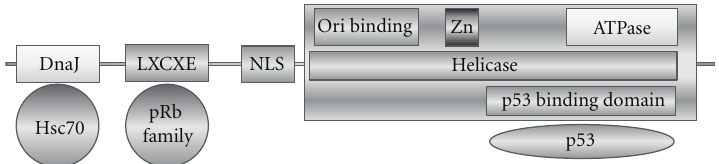
Figure 2: Polyomaviruses LT Ag structure. The functional domains are defined as follows: DnaJ domain that binds cellular Hsc70, LXCXE motif that binds the proteins belonging to the pRb family, NLS domain, that is the nuclear organization signal, Helicase domain, and p53 binding domain, that binds the p53 cellular suppressor protein.